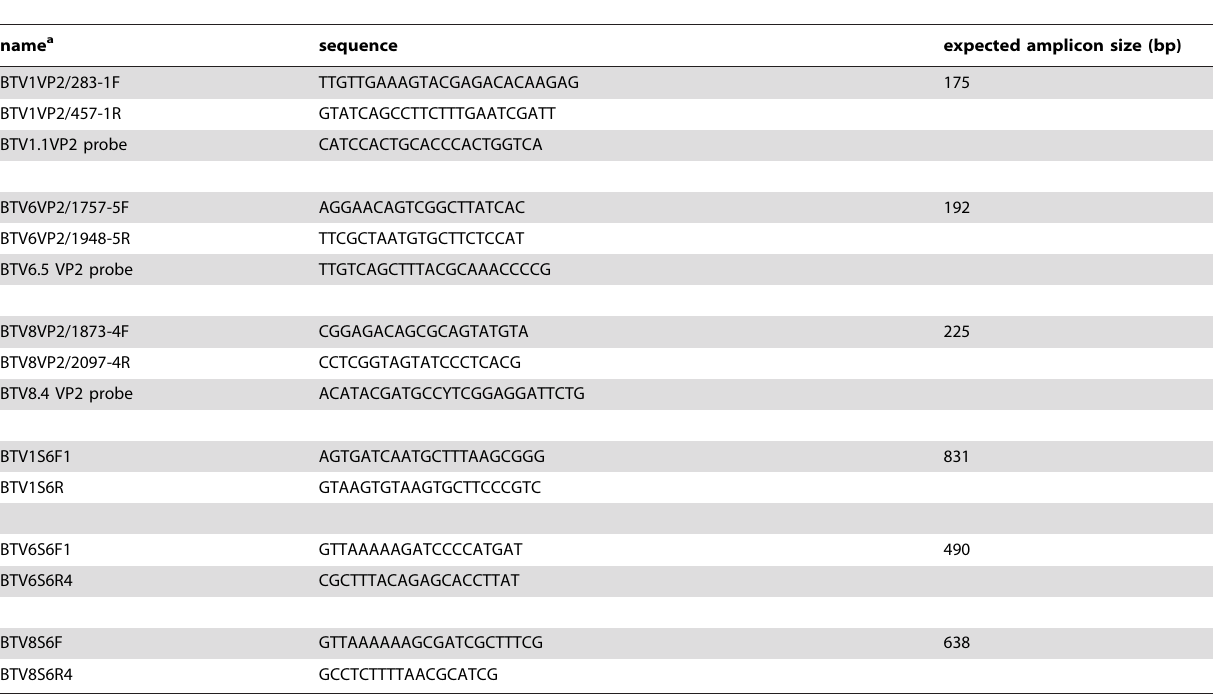
Table 1. Primers used for differential detection of genome segment Seg-2 (S2-genotyping) and Seg-6 of BTV serotype 1, 6, and